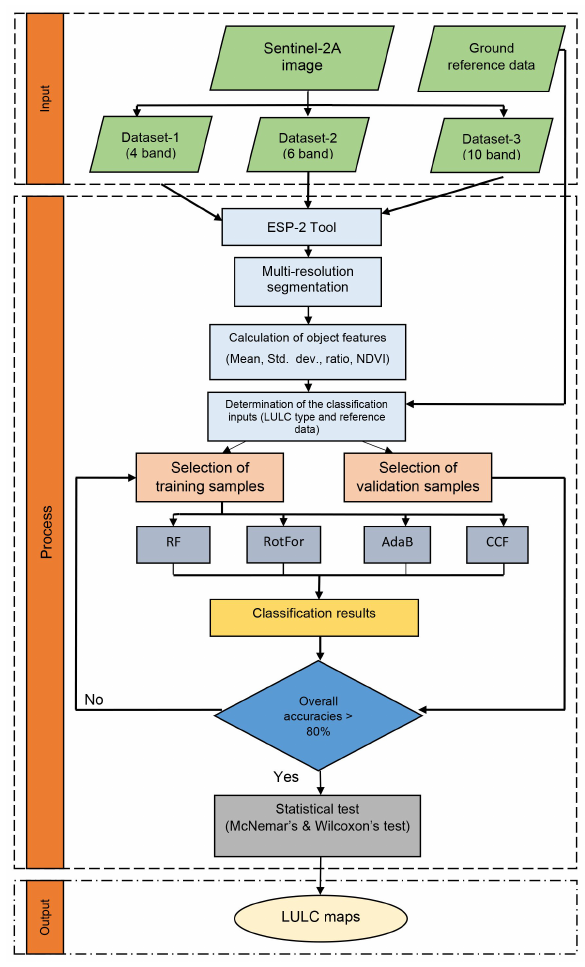
Figure 2: Flowchart of methodology performed in this